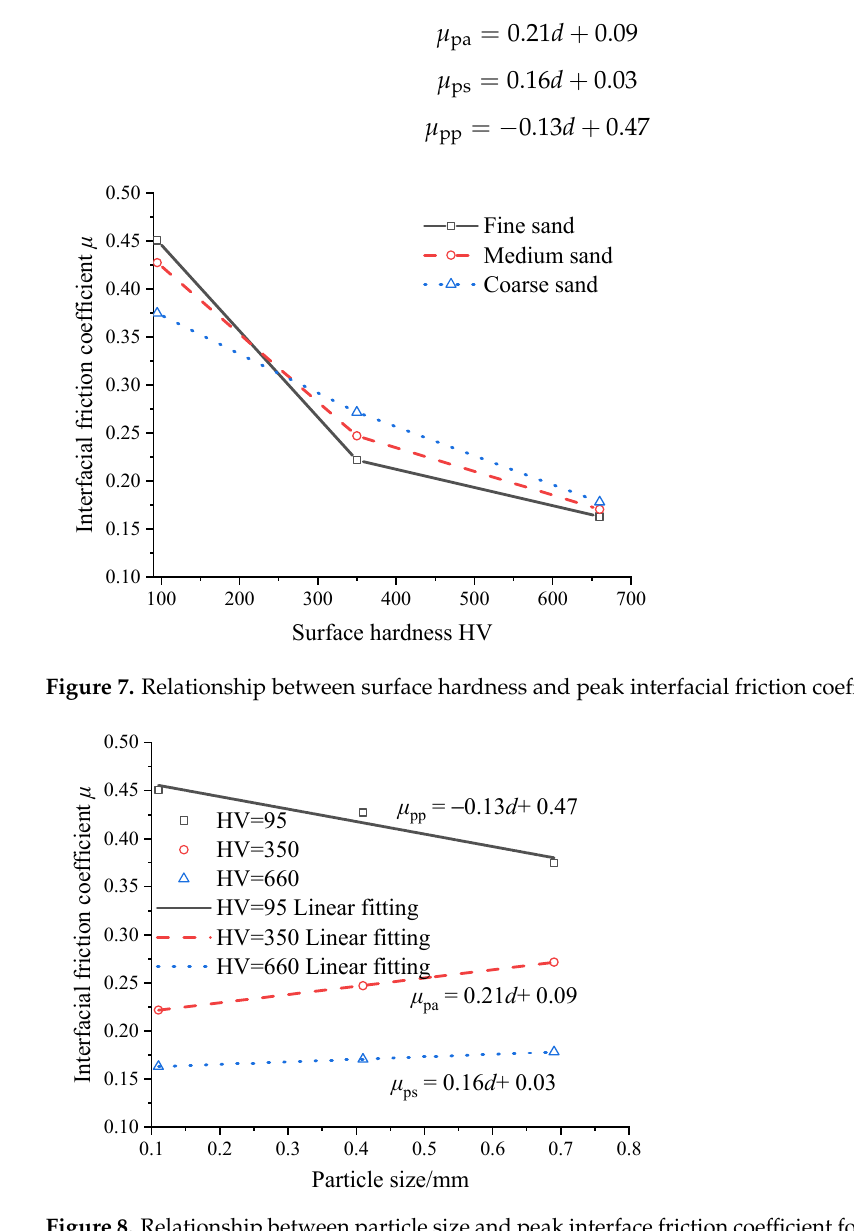
Figure 8. Relationship between particle size and peak interface friction coefficient for different surface hardness values.